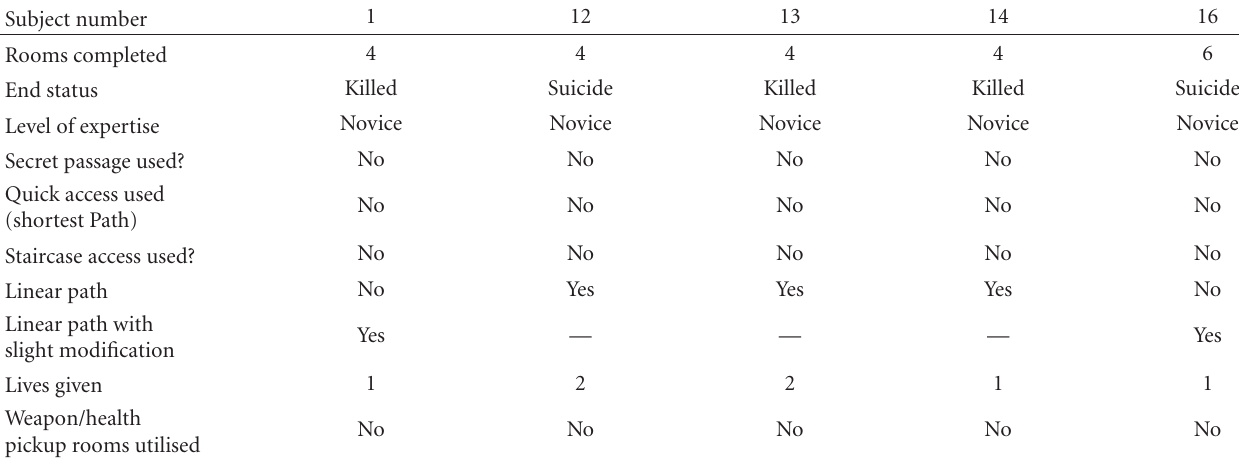
Table 2: Fundamental information regarding the five worst